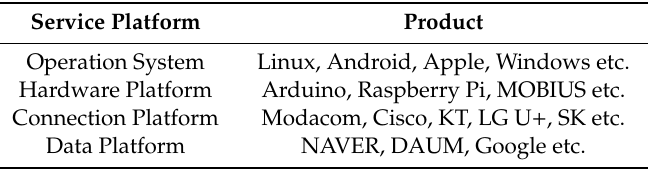
Table 2. Various platforms supporting IoT.